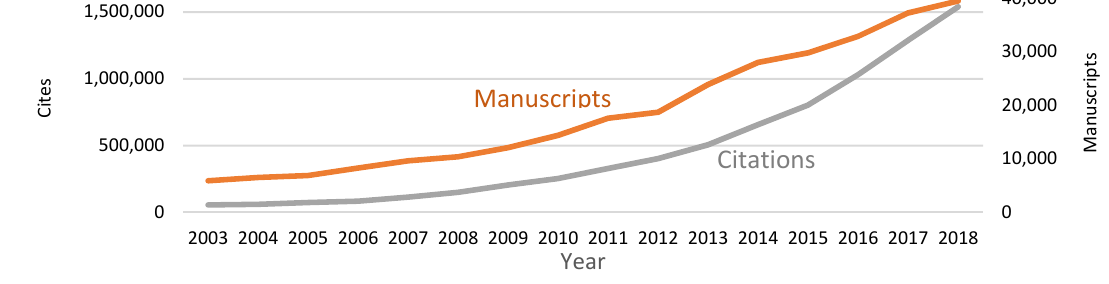
Figure 2. Evolution of citations and articles in the category energy and fuels.